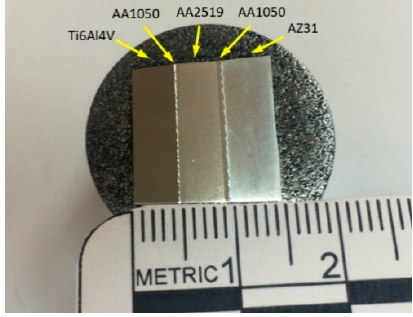
Figure 3. Cross-section of the obtained multilayer composite.